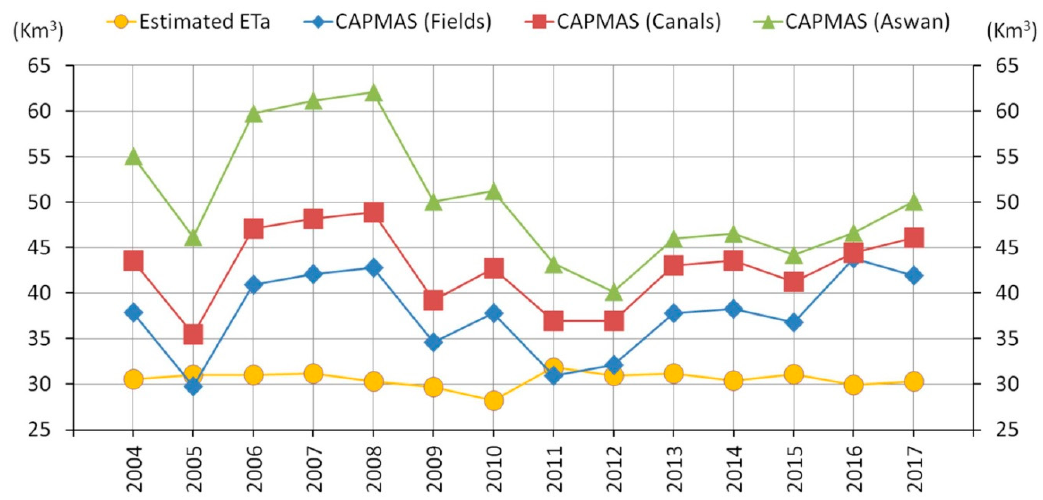
Figure7. Theannual ETafromSSEBopandthe irrigationdatapublishedby CAPMASfordi ff Figure 7. The annual ETa from SSEBop and the irrigation data published by CAPMAS for different scales.